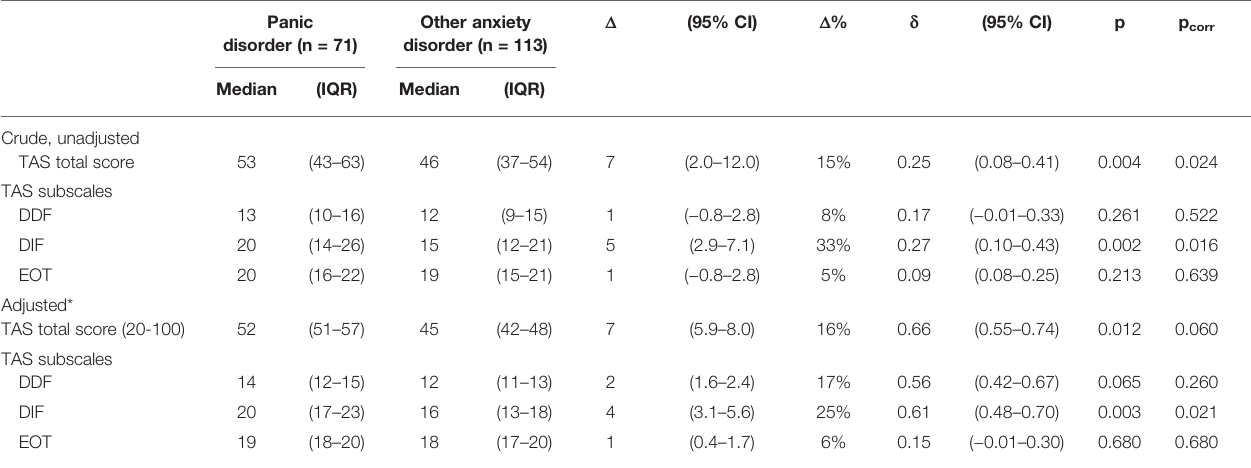
TABLE 2 | Toronto Alexithymia Scale (TAS-20) results in two study